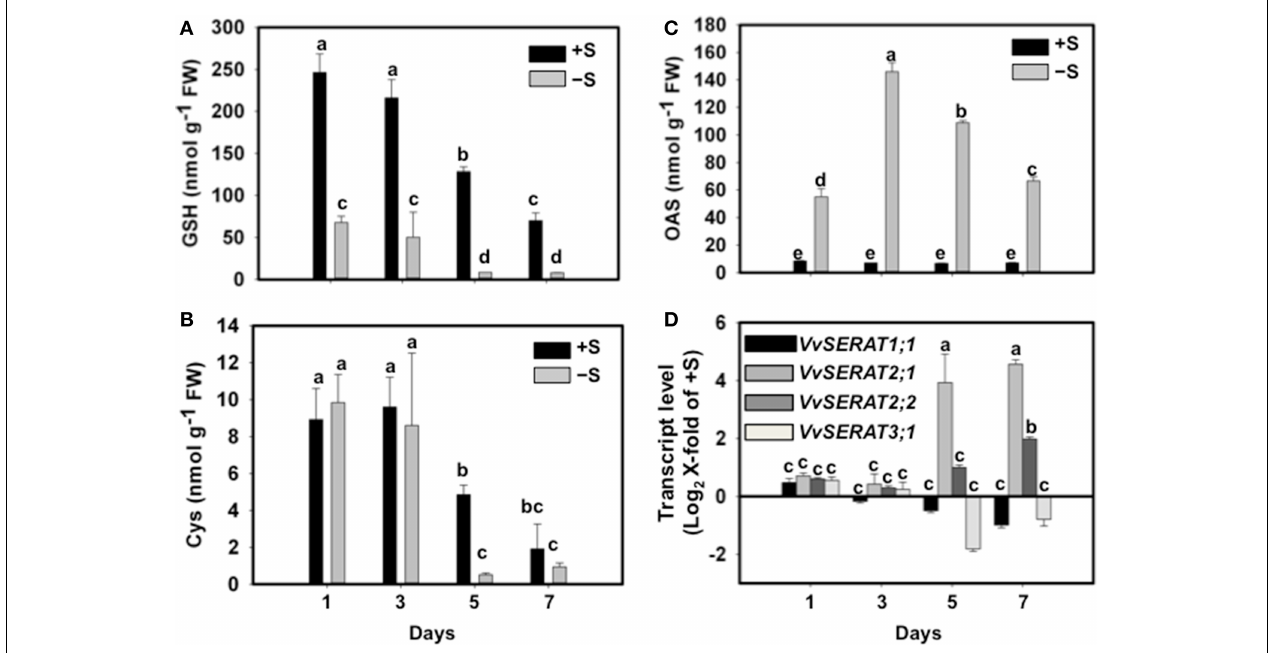
of growth. cDNA obtained from RNA extracted from cell suspensions was normalized against the expression of Act2 RNA as described in Methods. The raw Ct values for Act2 expression in V. vinifera cells were 18.3 and 19.1 at day1, 18.1 and 17.8 at day 3, 18.9 and 18.2 at day 5, and 19.6 and 19.1 at day 7, respectively under − S and + S conditions. Error bars represent ± SD; n = 6. Different letters indicate statistically significant differences using Two-Away ANOVA ( p < 0 .